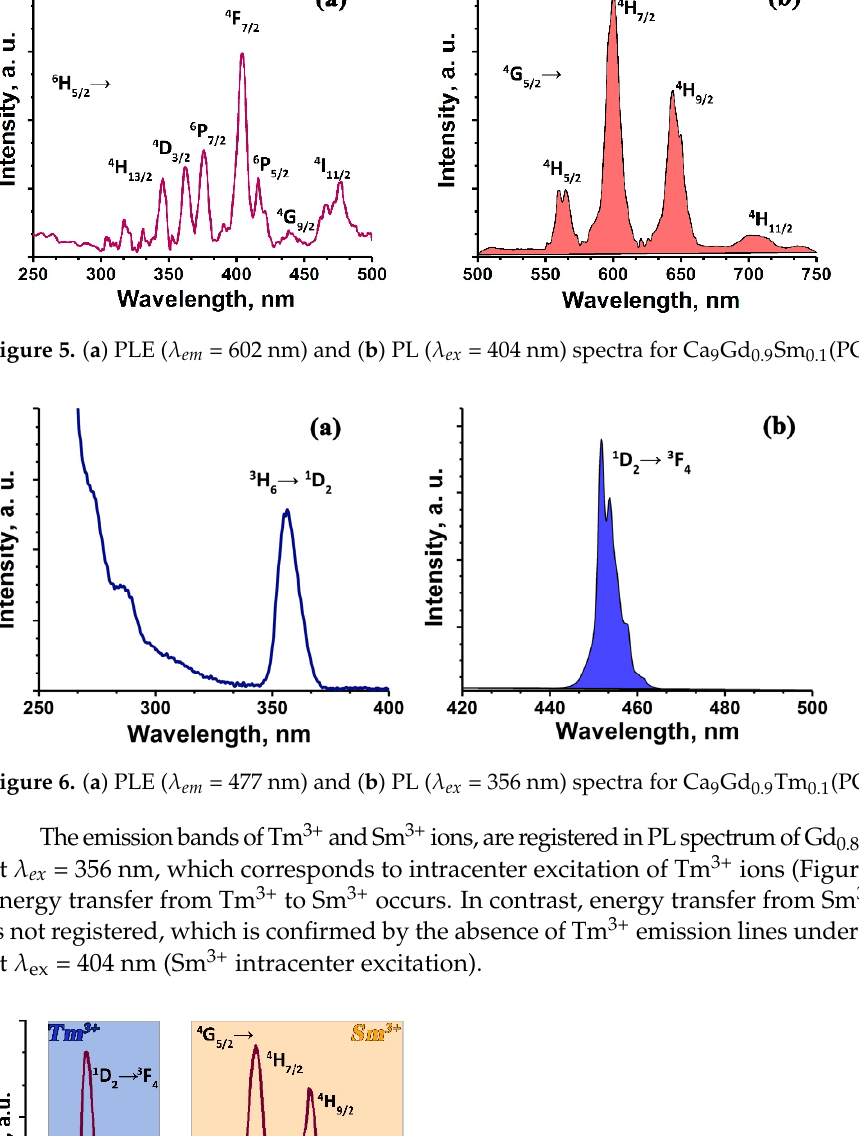
Figure 5. ( a ) PLE ( λ em = 602 nm) and ( b ) PL ( λ ex = 404 nm) spectra for Ca 9 Gd 0.9 Sm 0.1 (PO 4 ) 7 . The PLE spectrum of Gd 0.9 Tm 0.1 , monitored at λ em = 477 nm, is presented in Figure 6a.